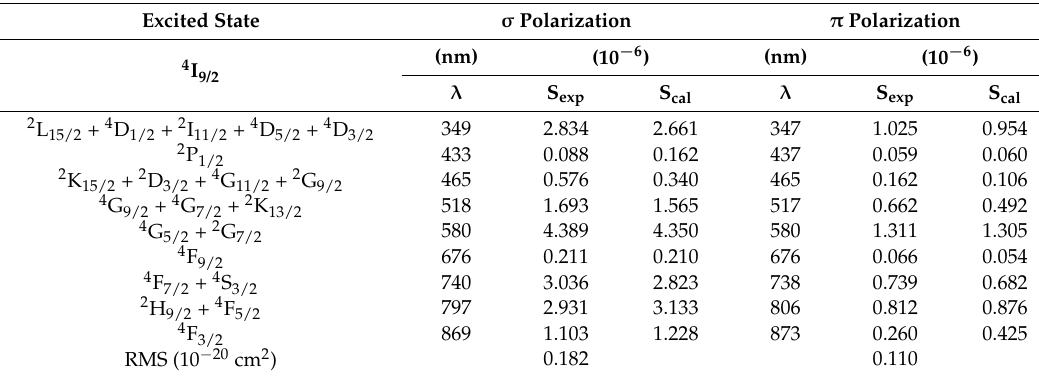
Table 1. The average wavelength of different transitions, the line strength of the experiment and calculations, and RMS (root mean square error caused by spectral parameters through J–O theory) deviation of Nd:ASL crystal.